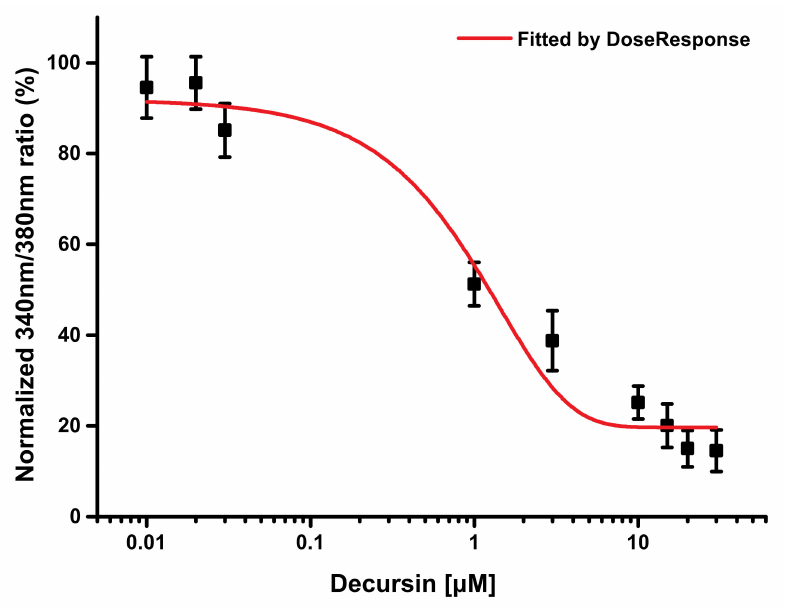
Figure 4. Intracellular Ca 2+ levels after treatment with decursin in TRPV1-expressing HEK293 cells sensitized by capsaicin. These cells were exposed to different concentrations of decursin in the presence of capsaicin. The ∆ 340/380 ratio (%) at each decursin concentration was calculated by the same method as that reported in Figure 1B. The red line indicates the dose–response curve that was obtained using OriginPro software. This experiment was conducted in triplicate.